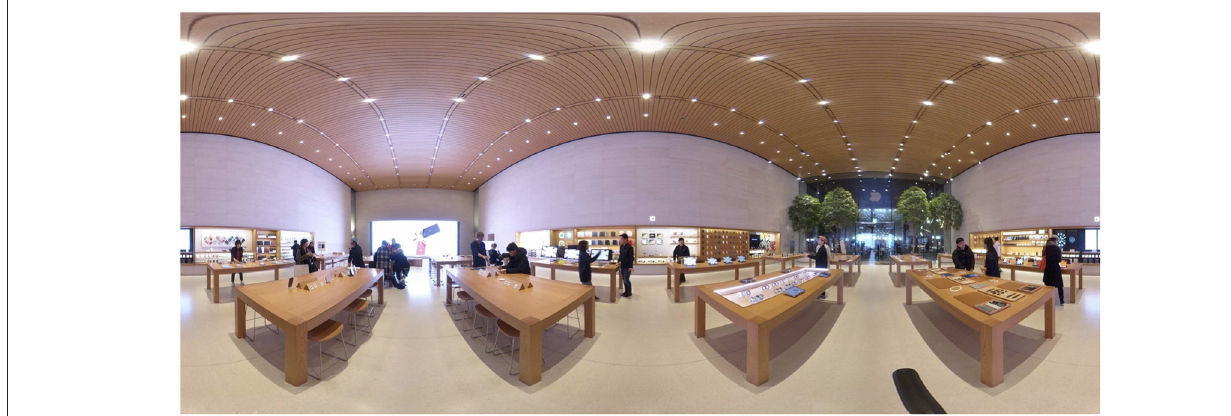
FIGURE 1 | 360 ◦ panoramic image of Stimulus 1.